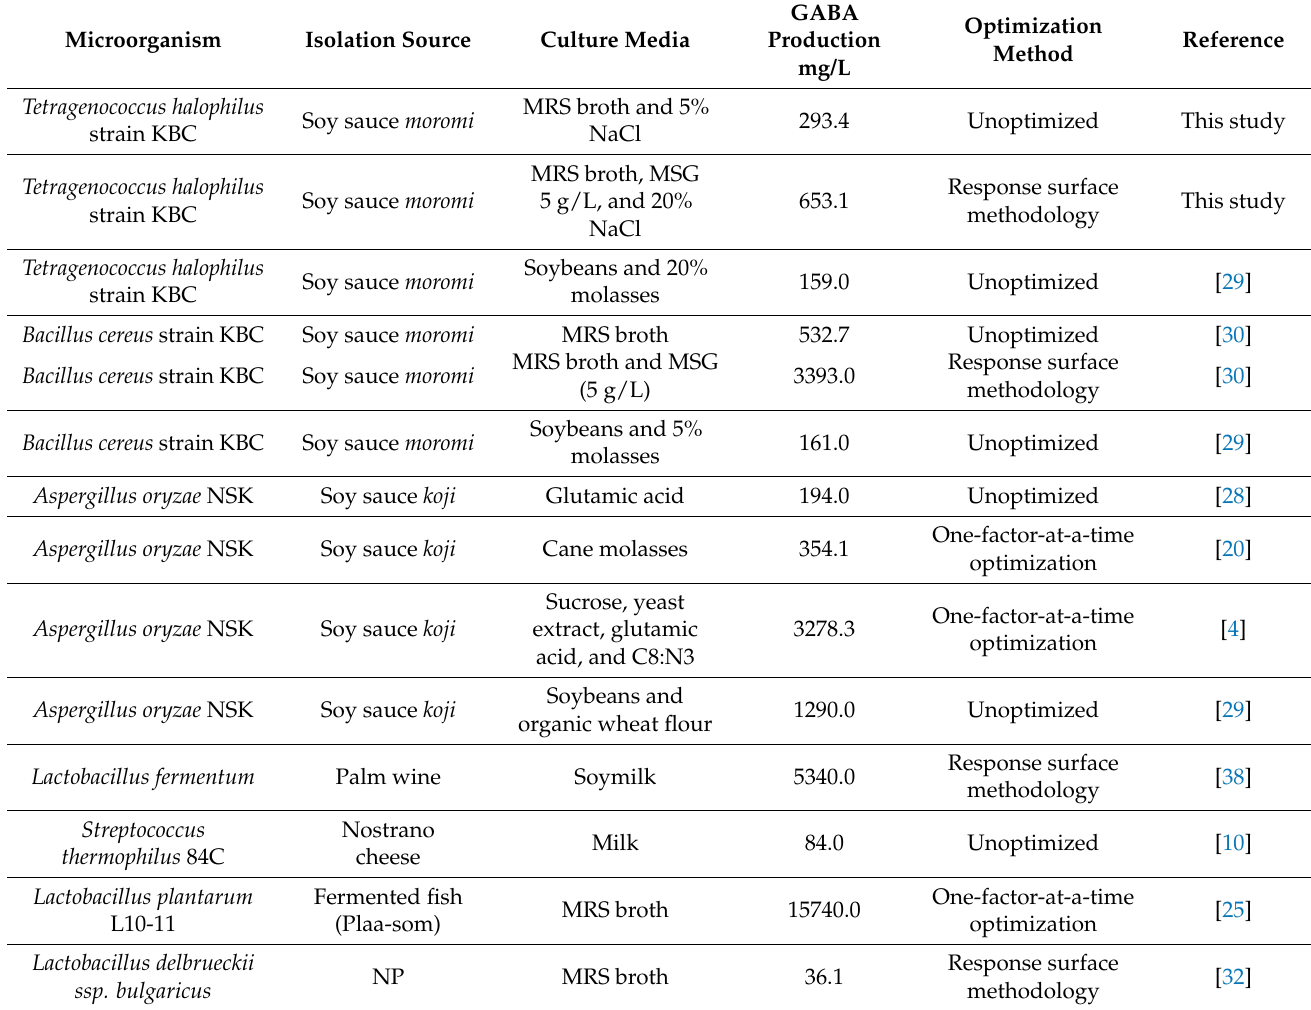
Table 4. GABA-producing abilities of critical microorganisms from fermented food